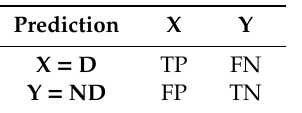
Table 6. Simple confusion matrix